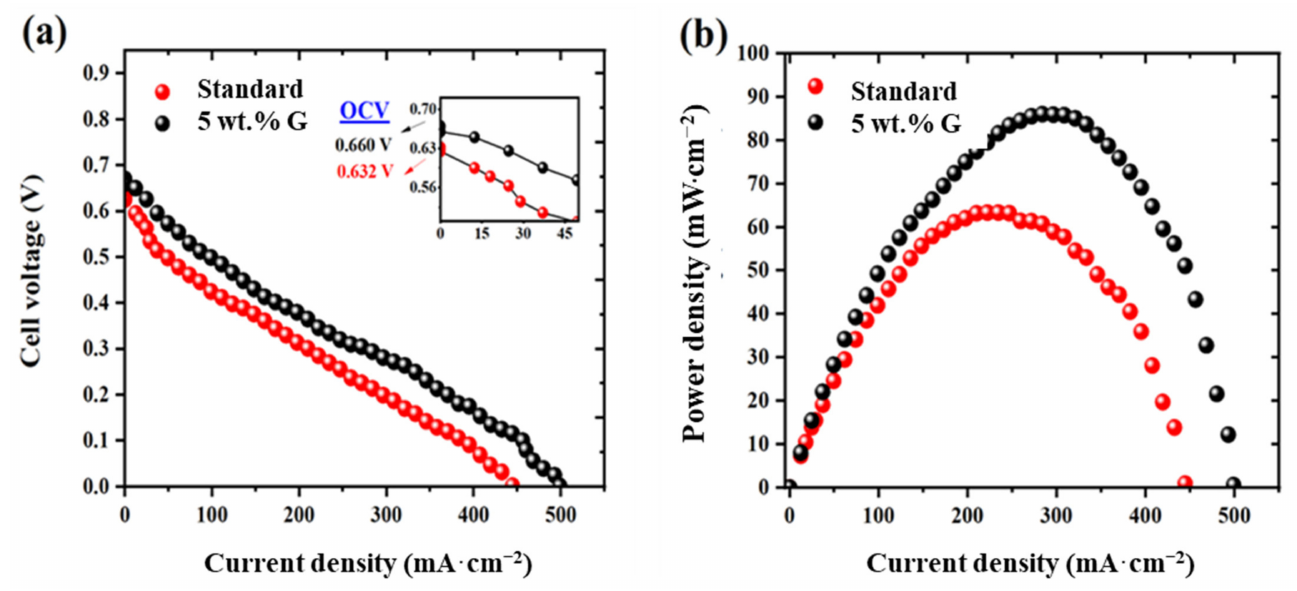
Figure 5. ( a ) Cell voltage and ( b ) power density profile obtained at 60 ◦ C in 1 M methanol/oxygen conditions for standard and 5 wt.% graphene